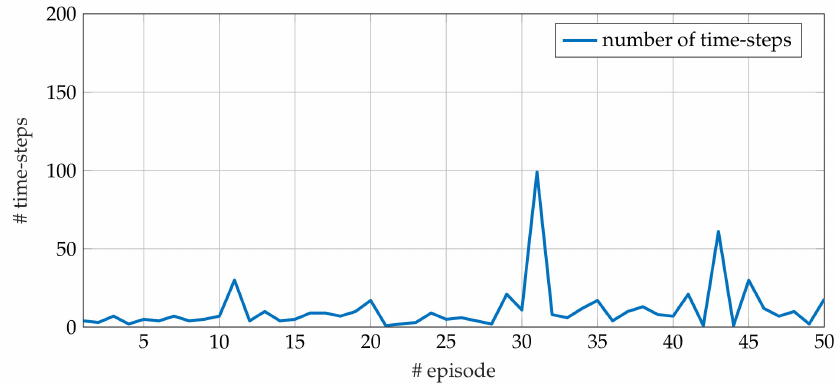
Figure 6. Number of time-steps for each episode during a single run of test performed on the FERMI FEL